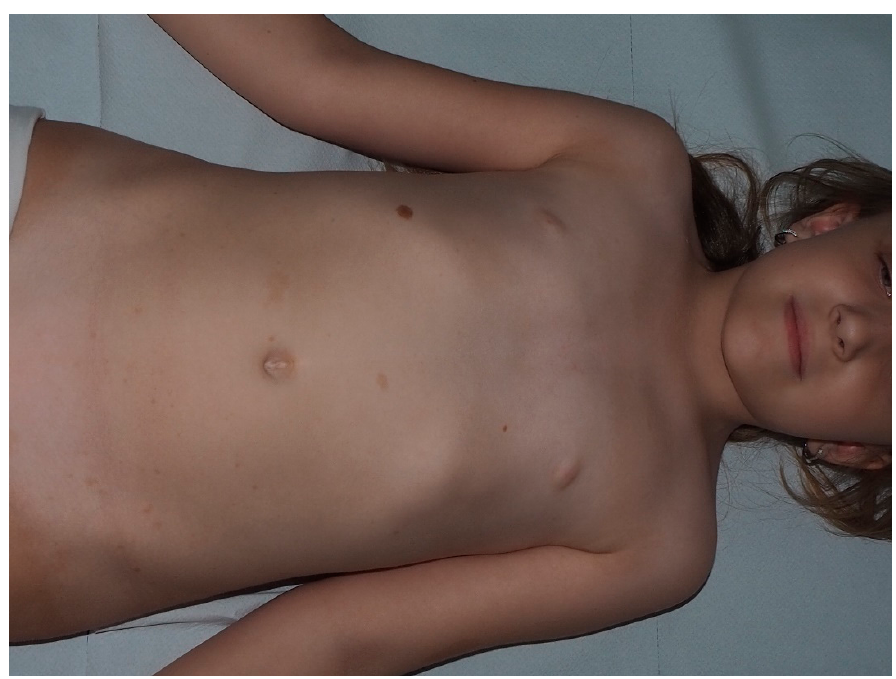
Figure 14. Small congenital nevus associated with multiple CALMs in a girl with NF1.